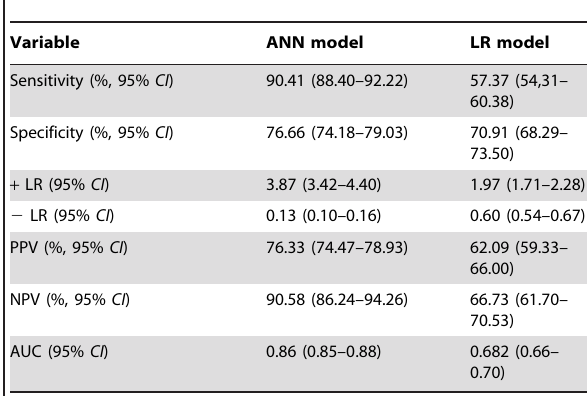
Table 3. Performance comparison of ANN and LR models for predicting dyslipidemia in the validation